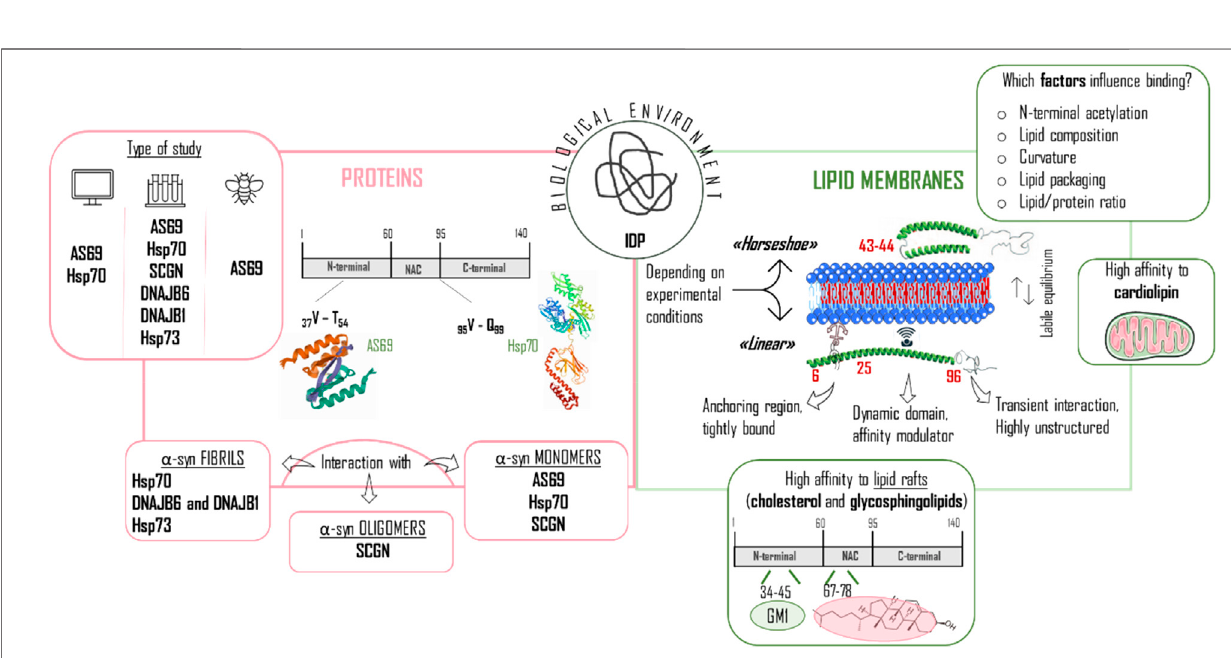
with endogenous small molecules.